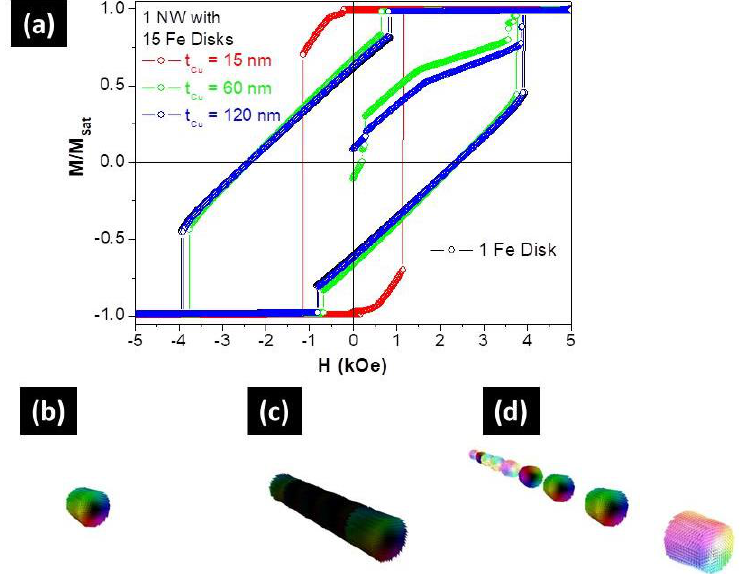
Figure 5. ( a ) Simulated hysteresis loops and virgin curves of one Fe disc (in black) and isolated multi-segmented Fe/Cu NWs with 15 discs of L Fe = 35 nm separated by L Cu = 15 (in red), 60 (in green), and 120 nm (in blue). 3D simulated magnetic configurations of ( b ) one Fe disc and isolated multi-segmented Fe/Cu NWs separated by L Cu of ( c ) 15 nm and ( d ) 120 nm, at the demagnetization state.